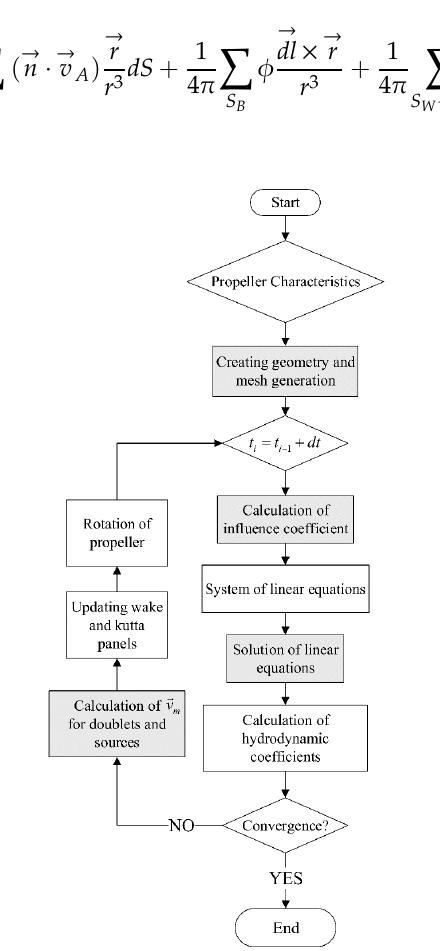
Figure 2. Flowchart of panel method.